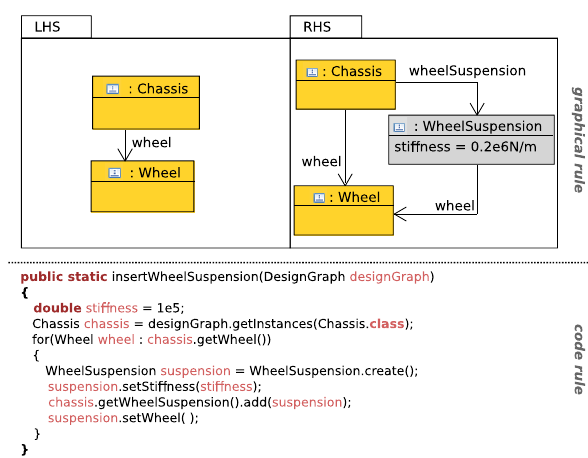
Fig. 5 Rule insertWheelSuspension : Equivalence of graphically defined rule (top) and code rule (bottom). Both implementation techniques execute equivalent graph manipulations on the design